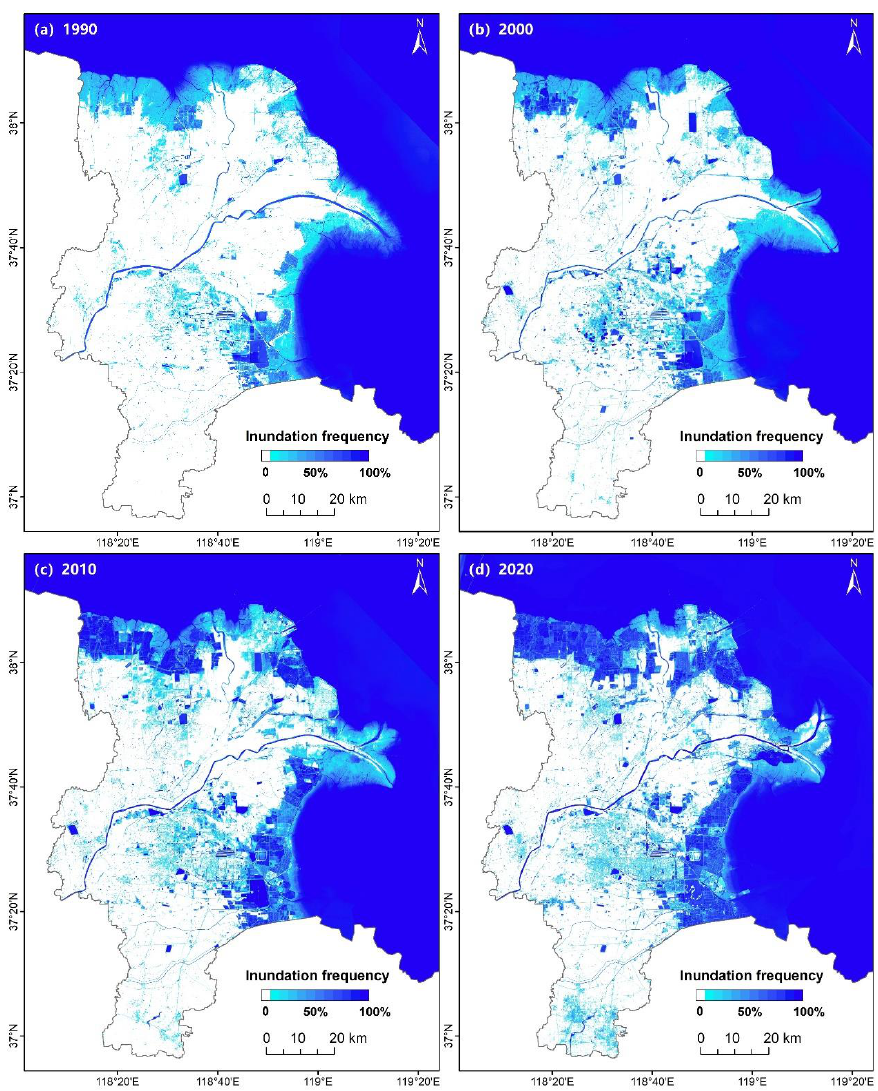
Figure 3. The spatial extent of different inundation area of ( a ) 1990, ( b ) 2000, ( c ) 2010, and ( d ) 2020 in the YRD.